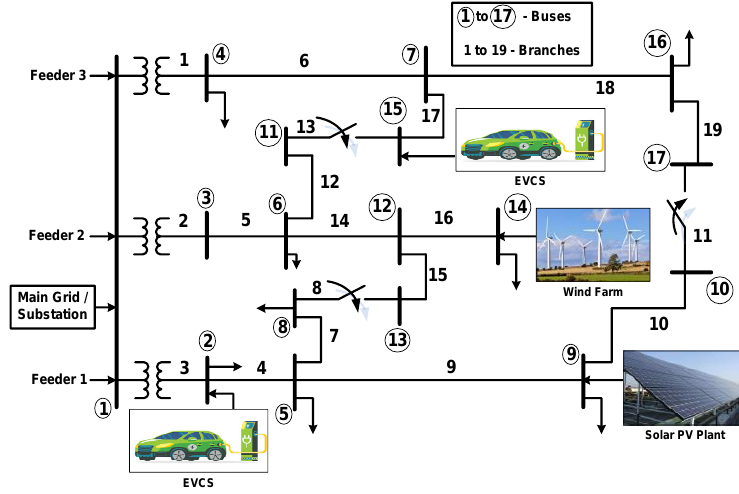
Figure 2. SLD of 17 bus distribution system (DS).